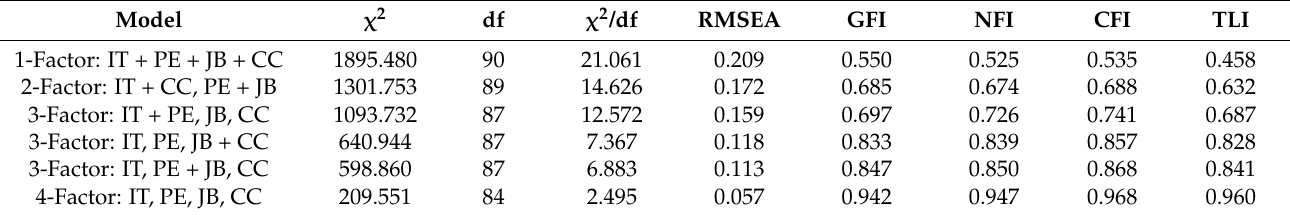
Table 2. Results of the confirmatory factor analysis.